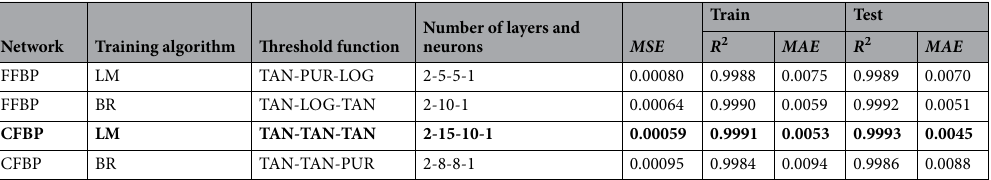
Number of layers and neurons